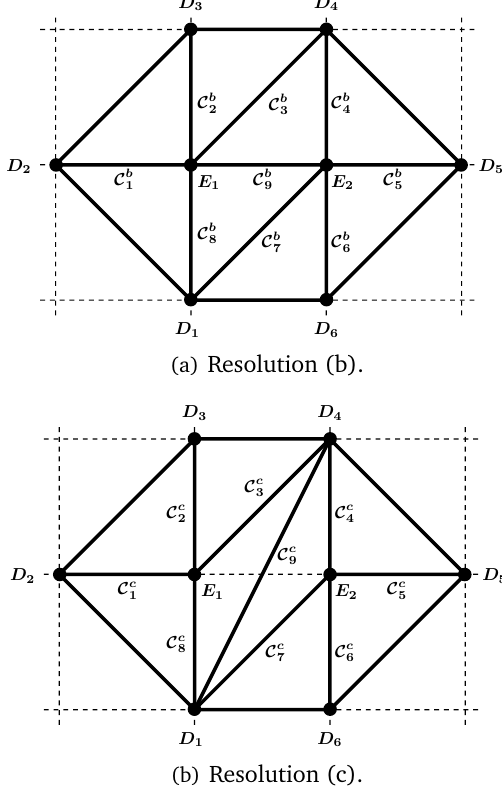
Figure 20: Resolutions (b) and (c), with all the curves